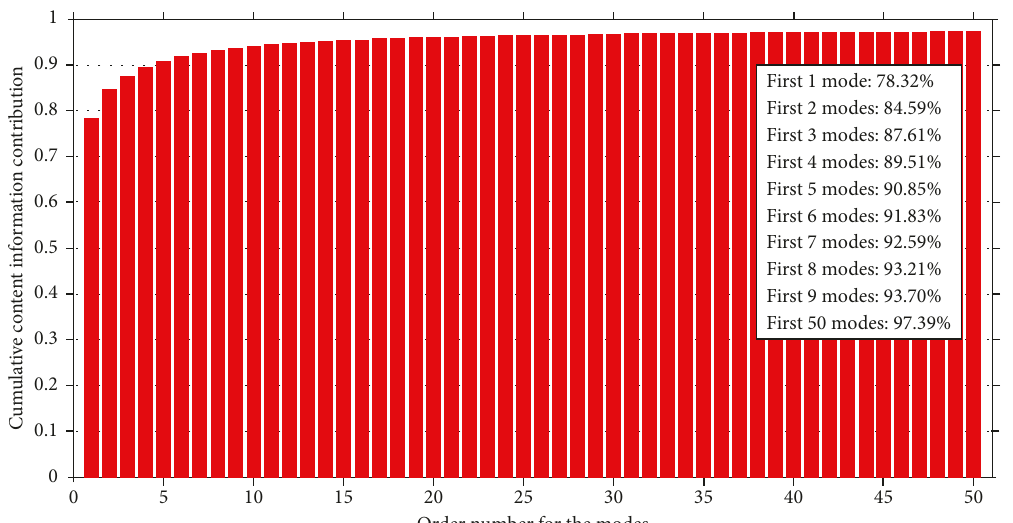
Figure 13: Cumulative content information contribution for the first 50 modes in the subsequent stage of flame